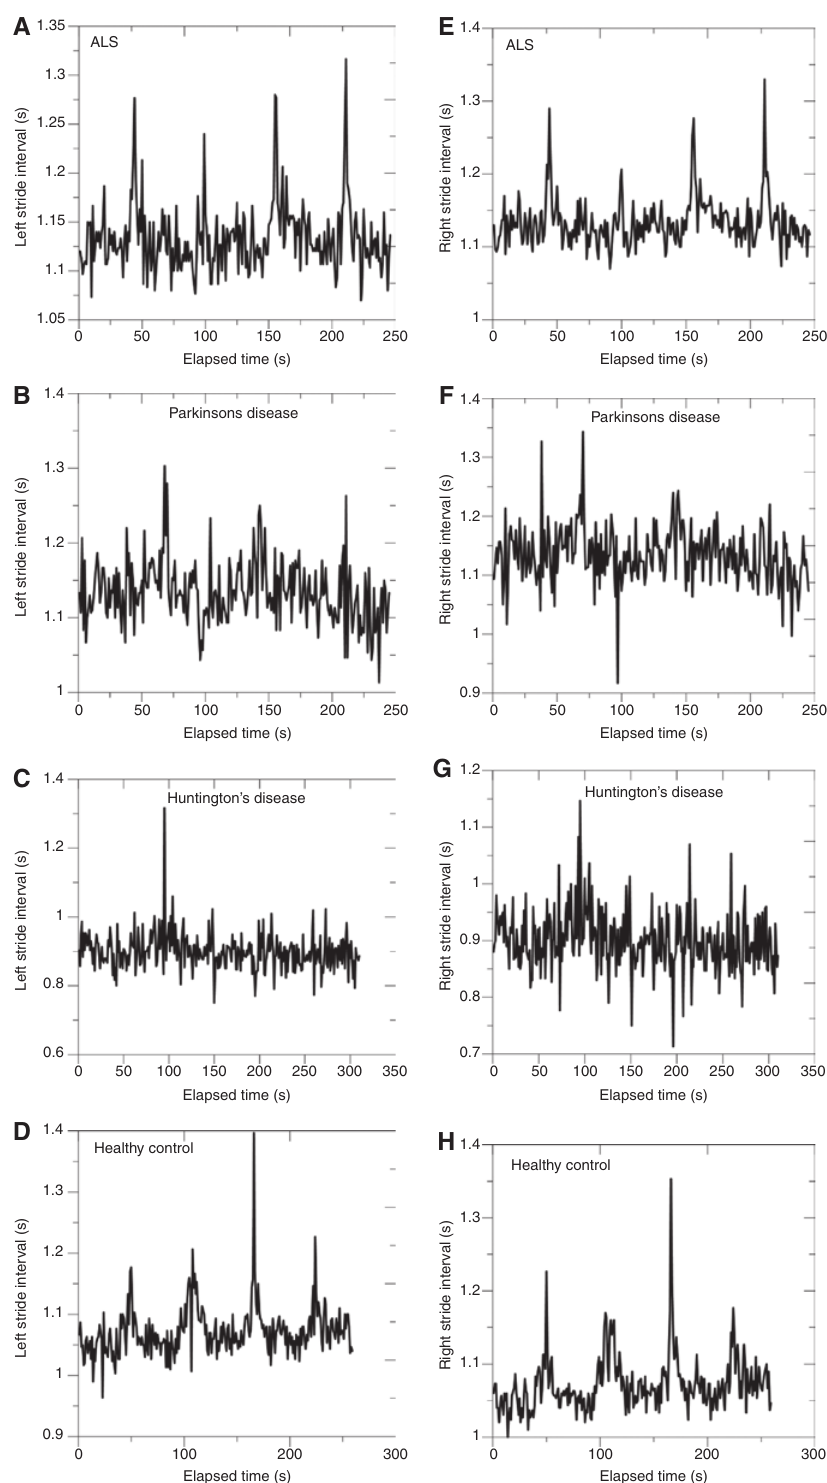
Figure 4: Examples of gait time series. (A) Left stride intervals for a patient with ALS. (B) Left stride intervals for a patient with Parkinson’s disease. (C) Left stride intervals for a patient with Huntington’s disease. (D) Left stride intervals for a healthy control subject. (E) Right stride intervals for a patient with ALS. (F) Right stride intervals for a patient with Parkinson’s disease. (G) Right stride intervals for a patient with Huntington’s disease. (H) Right stride intervals for a healthy control